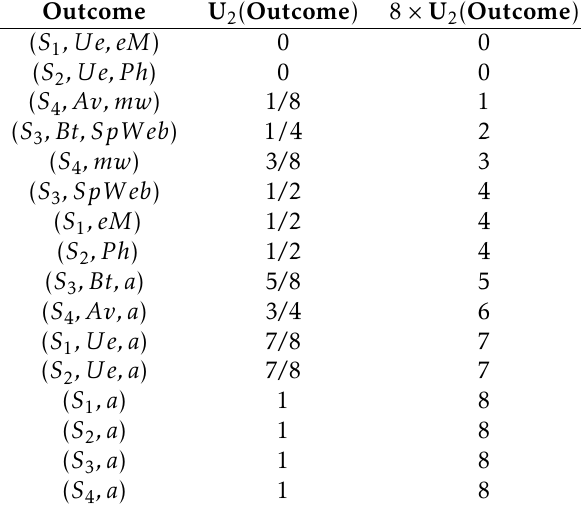
reaction ( D ij ) is associated with a utility obtained from [42]. D 21 is associated with a utility of 4 for the defender and a utility of 16 for the